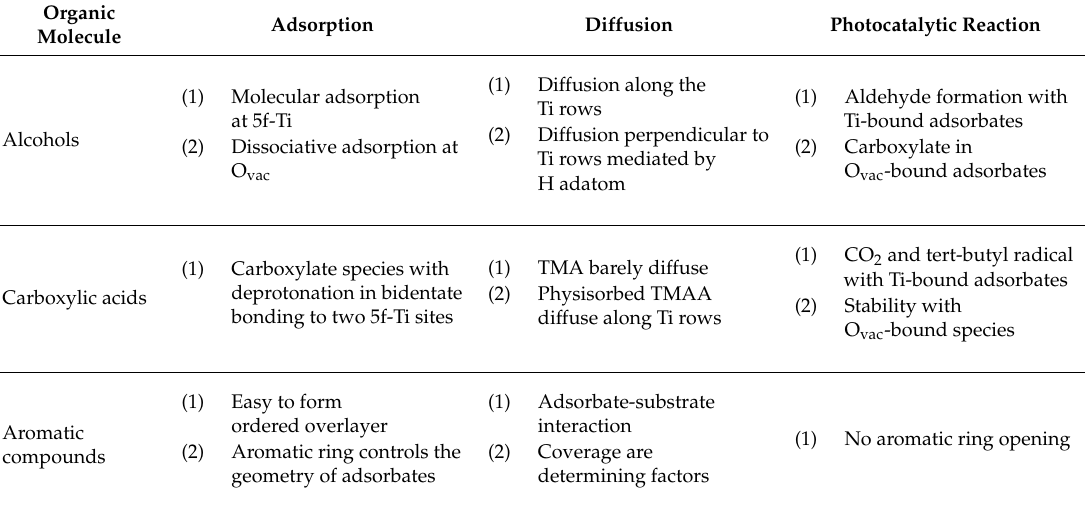
Table 1. Common traits in the behavior of adsorption, diffusion and photocatalytic